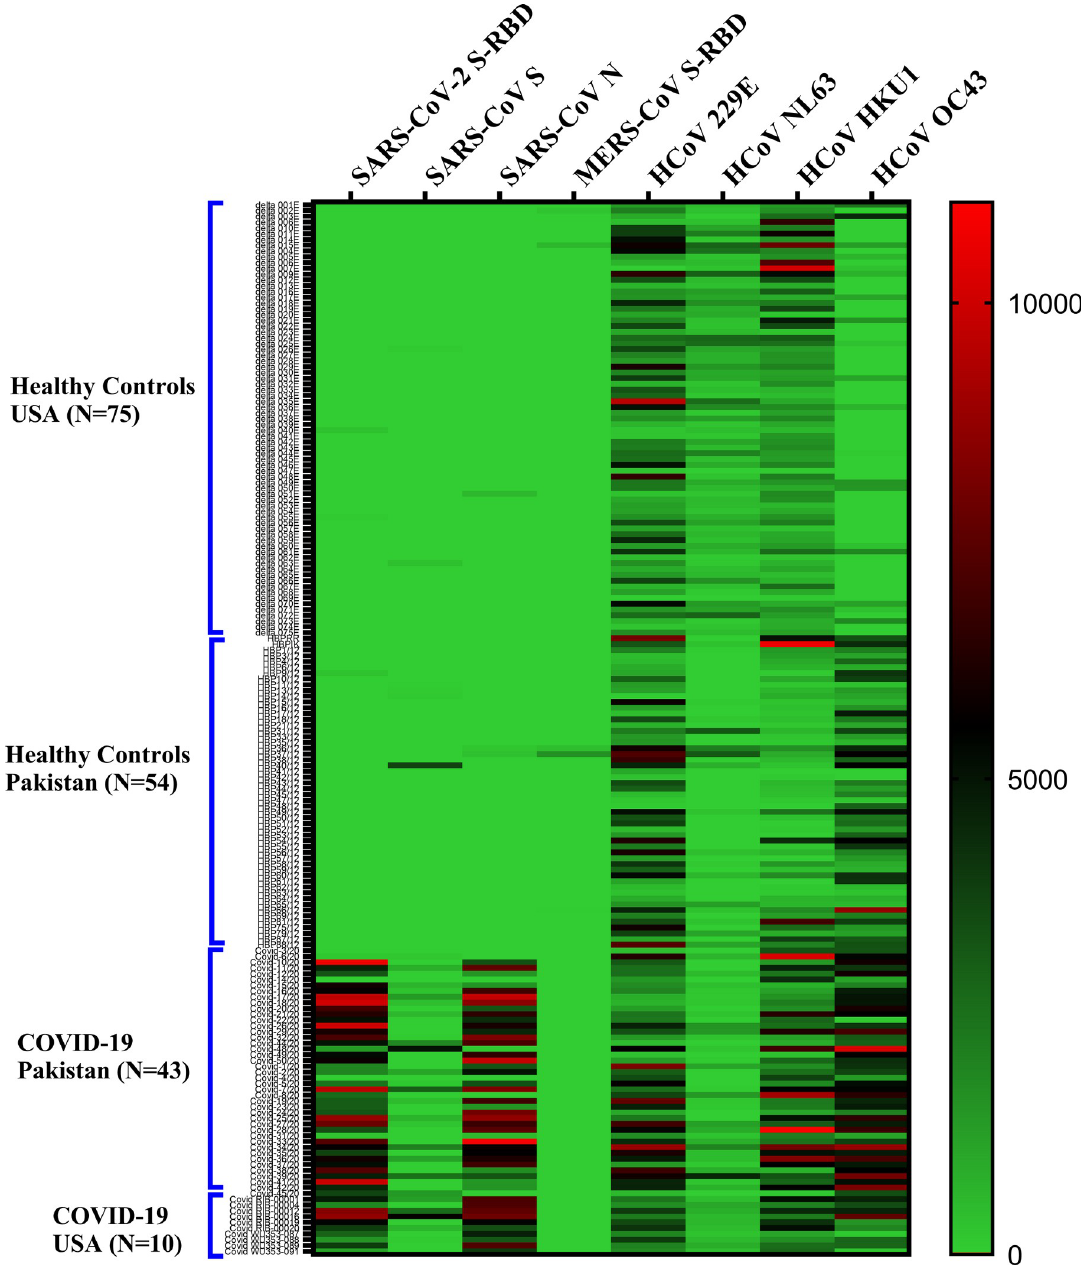
Fig 2. Heat map depicting overall antibody responses detected by multiplex microbead panel against members of the coronavirus family (SARS-CoV-2; SARS-CoV; MERS-CoV and 4 common coronaviruses (229E, NL63, OC43, HKU1)) in COVID-19 patients and healthy controls. Antibody responses (IgG) to SARS-CoV-2 S-RBD; SARS-CoV S and N; MERS-CoV S-RBD; and S proteins of 4 common coronaviruses are shown. In patients where multiple time points were available, the latest time point after the onset of symptoms is shown. Each row corresponds to one sample and columns correspond to CoV antigens in the multiplex assay. The color intensity scale represents the relative MFI (median fluorescent intensity) values ranging from the highest (10,000; red) to no antibody response (0; green). No significant background reactivity to SARS-CoV-2 S-RBD, SARS-CoV S, SARS-CoV N, and MER S-RBD was detected in healthy controls from US and Pakistan. SARS-CoV-2 with some cross-reactivity to S protein of SARS-CoV (as well as to S proteins from common coronaviruses). Plasma samples from confirmed COVID-19 patients (n = 49)